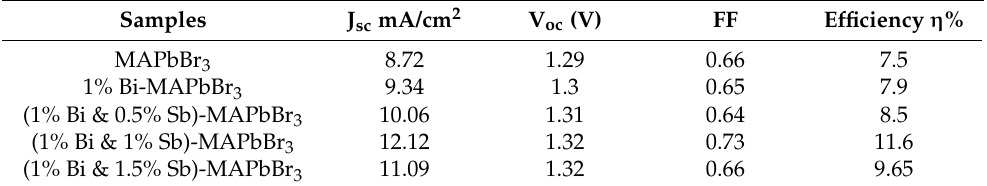
Figure 7. J-V curve of pure MAPbBr 3 and 1% Bi and (0%, 0.5%, 1%, 1.5%) Sb co-doped MAPbBr 3 based solar cells. Table 2. J-V parameters of MAPbBr 3 and 1% Bi and (0%, 0.5%, 1%, 1.5%) Sb co-doped MAPbBr 3 solar